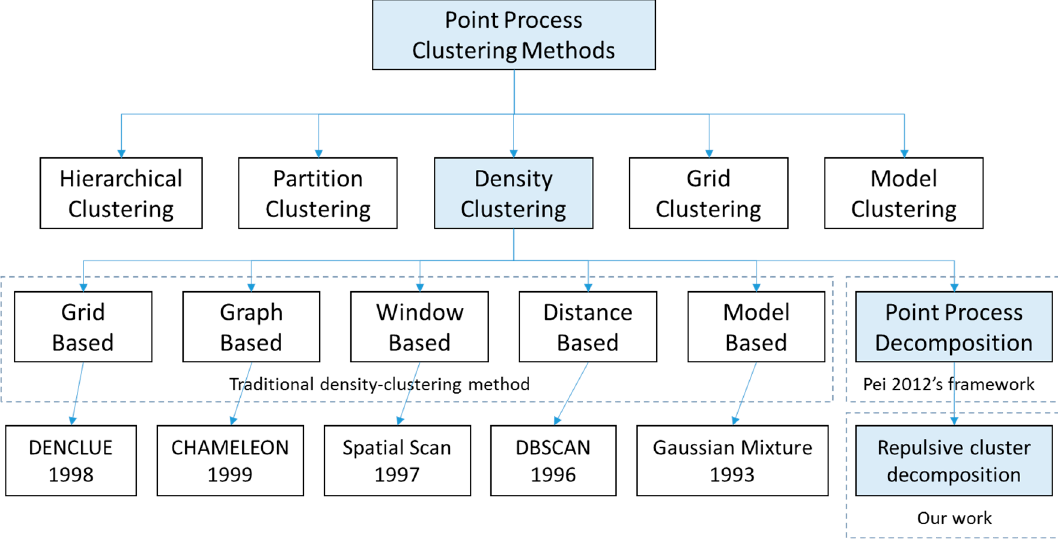
Figure 1. Taxonomy of point process clustering methods.